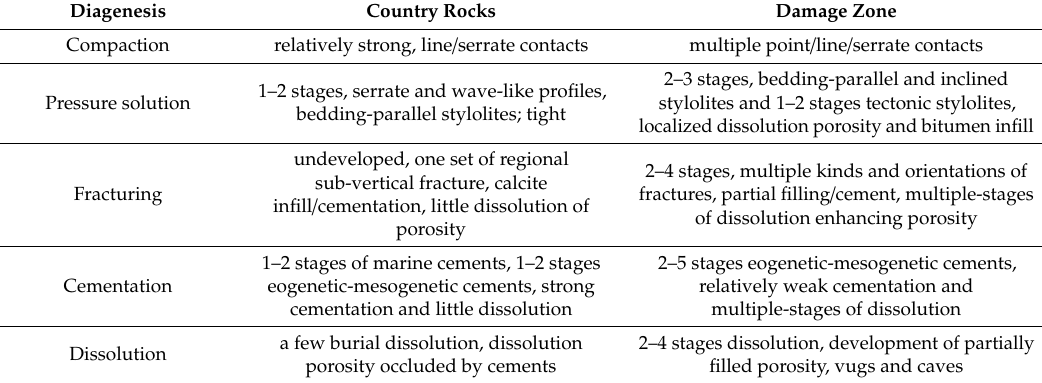
Table 1. A comparison of diagenesis between fault damage zones and country